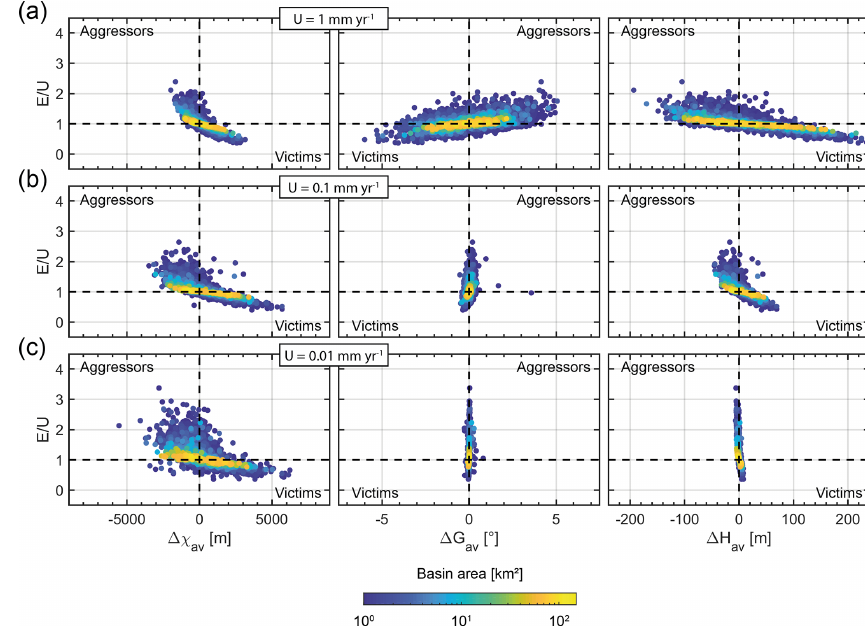
Figure 8. Sensitivity to uplift rates. Colour scale indicates basin area. Basins of variable sizes are sorted into seven area classes expanding geometrically with a multiplying factor of 2 from 1–2 to 64–128km 2 , every 0.5Myr over the time period 5–10Myr. Basins with a confidence index lower than 50% are discarded from the analysis. (a) Results with an uplift rate of 1mmyr − 1 . (b) Results with an uplift rate of